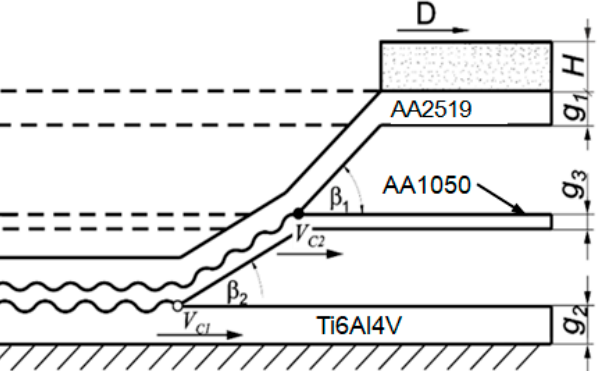
Figure 1. Schematic diagram of the collision course of explosion welded three-layer: β —angle of collision of combined materials, β 1 —angle of collision of base material with interlayer material, β 2 —angle of collision of overlay material with interlayer material V c —velocity of collision point with respect to contact point of welded plates, V c1 —velocity of collision point of contact between base material and interlayer material, V c2 —velocity of the collision point of the contact point of the base material and the interlayer, D—velocity of detonation of the explosive, H—height of the explosive layer, g 1 —thickness of the plate to be shot, g 2 -thickness of the base plate, g 3 —thickness of the interlayer.